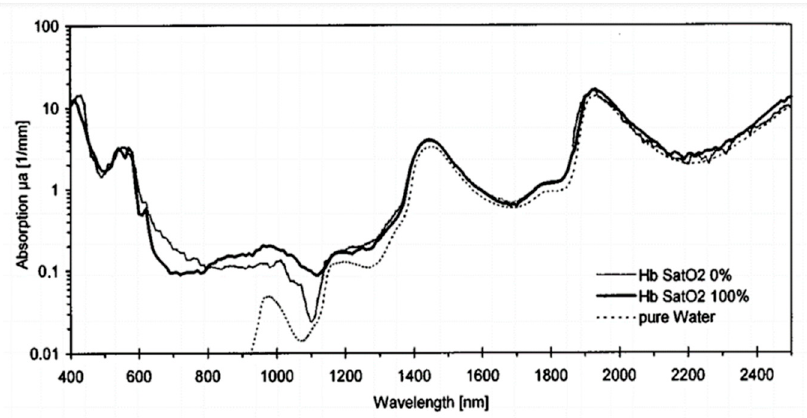
Figure 1. Different absorption of Hb and HbO 2 in visible light and infrared light [16].